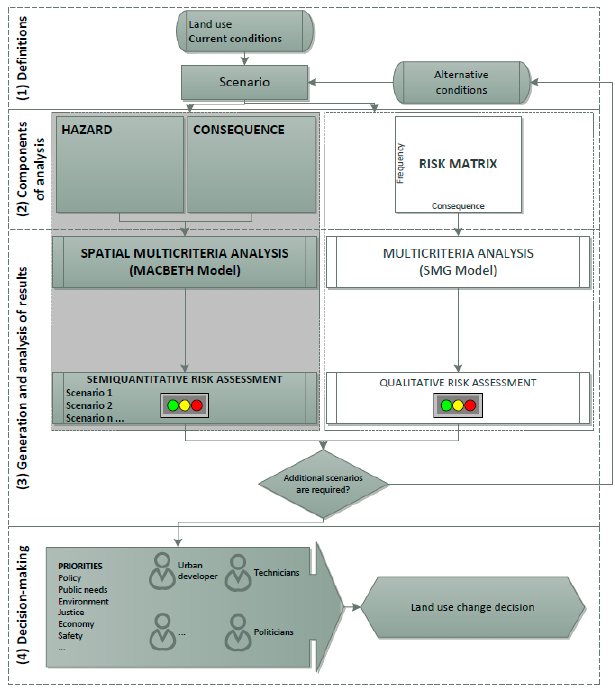
Figure 1. RiskOTe simplified workflow.